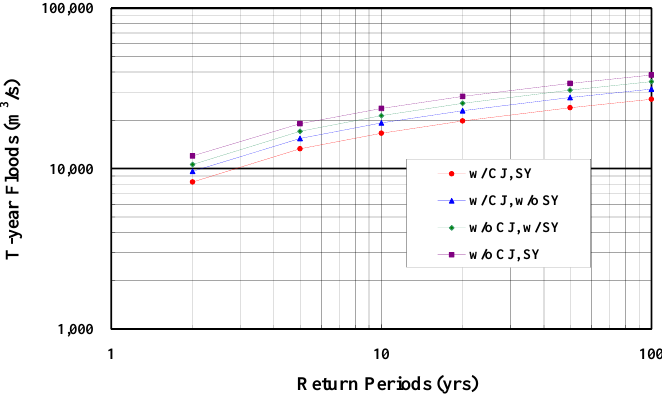
Figure 10. Flood Change for different Return Periods according to the Scenarios (Daily). T-year represents the different return period. Table 4. Percent Increase in T-year Floods according to the Scenarios (Daily) (%). Table 5. Percent Increase in T-year Floods according to the Scenarios (Daily) (%). Scenarios